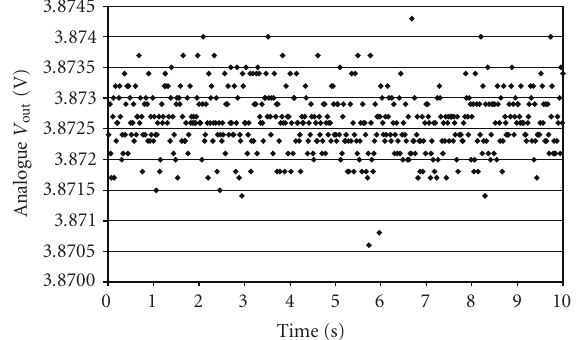
Figure 4: Noise measurements at output from analogue stage V out versus. Time. 10 second recording at 50 Hz sample rate (500 readings). Note: Output voltage from the analogue bu ff er stage = 3.8726 V which comprises A/D converter bias voltage plus averaged noise voltage component, E ( t ). Uncertainty (95% confidence limits) = ± 44 μ V when measured over a 10 s period.